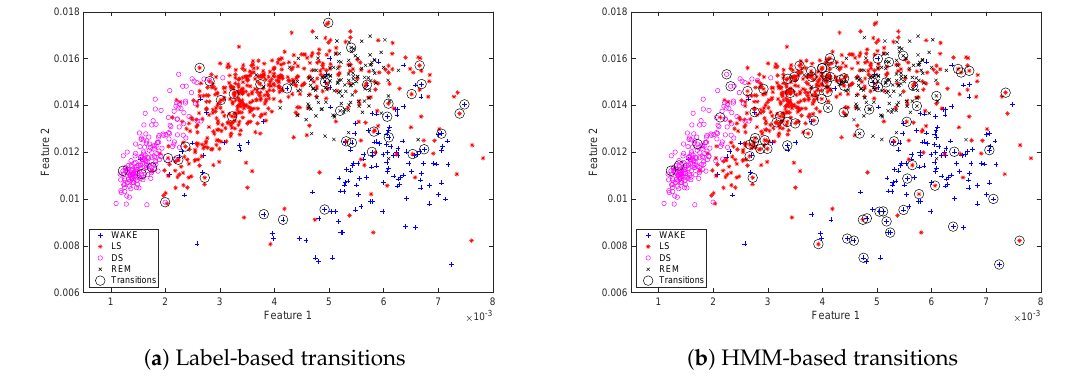
Figure 3. Scatter plot of two features with label transition instances ( a ) and HMM states transition instances ( b ) marked as black